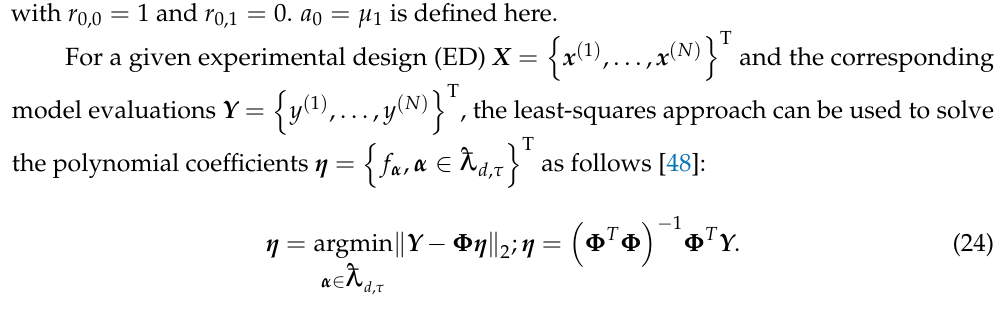
Figure 2. Framework of the SSR-ETM and ETM.